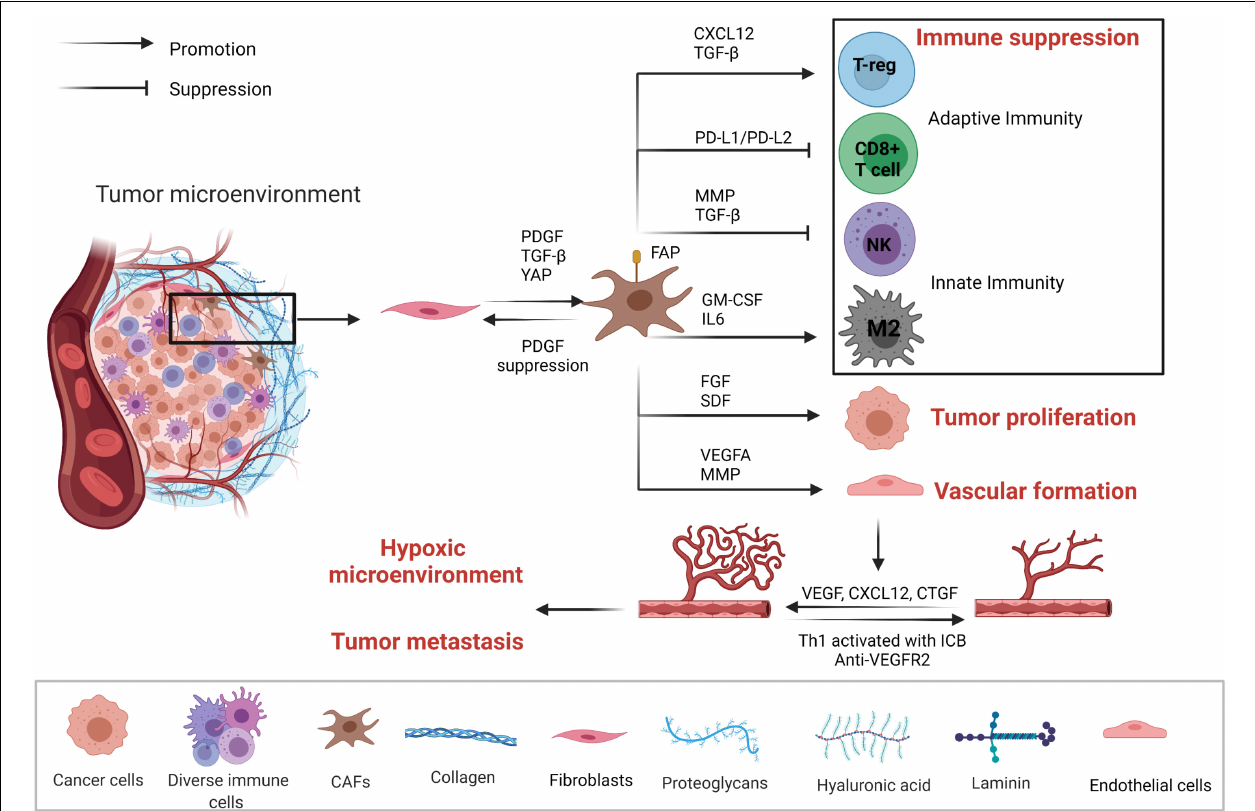
FIGURE 2 | Mechanisms of tumor-associated fibroblasts (CAFs) and vascular endothelial cells affecting the TME. CAFs, vascular endothelial cells, tumor cells, and immune cells are in a dynamic relationship. CAFs through the secretion of cytokines and PD1/PDL1, PDL-2 pathways form the immunosuppression microenvironment to promote tumor proliferation. Tumor microenvironment regulates vascular endothelial cell proliferation and the formation of blood vessels through the secretion of growth factors and cytokines. Eventually, TME becomes hypoxic, accelerating tumor metastasis.